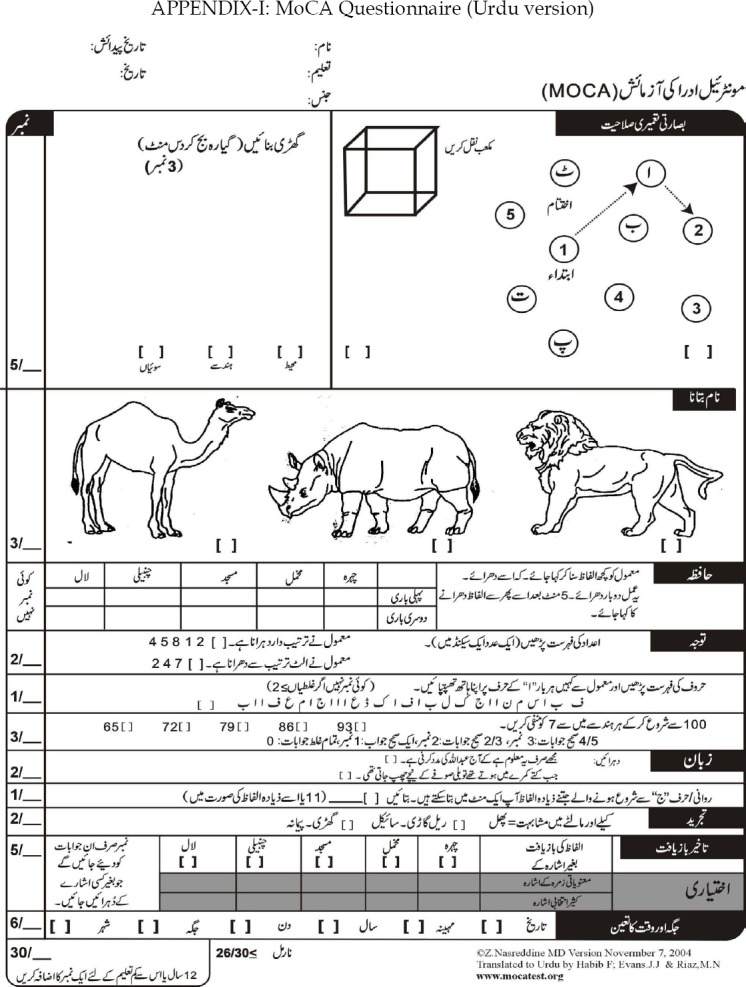
MoCA Questionnaire (Urdu version)